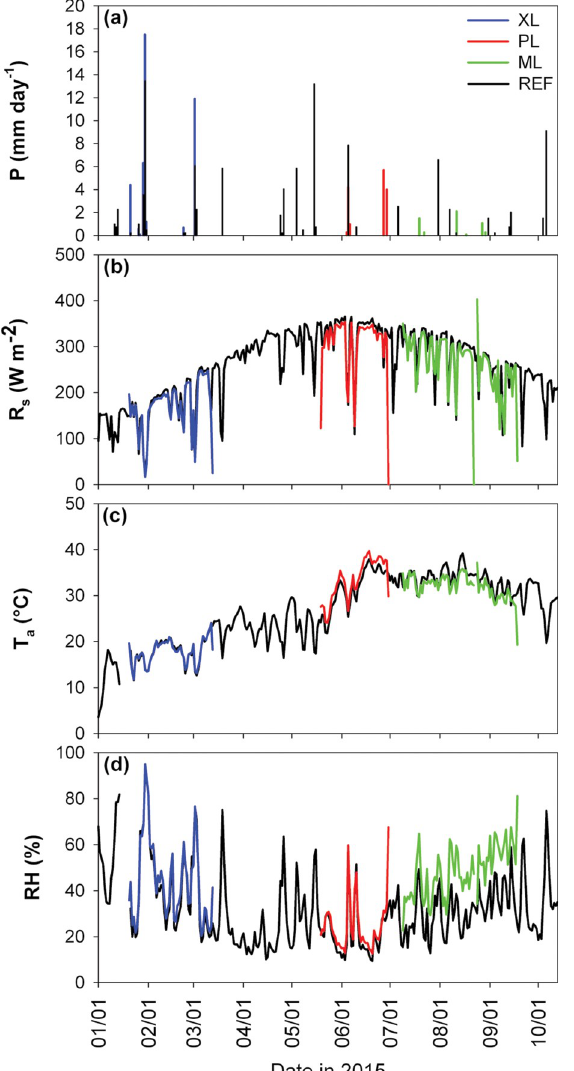
Fig 2. Meteorological conditions in the four sites. Comparison of meteorological measurements during entire study period (1 January to 30 September, 2015) including: (a) precipitation, (b) incoming solar radiation, (c) air temperature, and (d) relative humidity, shown as daily averages ( R , T , and RH ) or totals ( P ). s a https://doi.org/10.1371/journal.pone.0228537.g002 sites including compact low-rise [13,38, 39, 53], compact mid-rise [12,24, 48, 59, 82–86]and com- pact high-rise [50],reported values between 18.7 and 71.7 g CO m -2 day -1 during the summer. The 2 Pearson correlation coefficient (CC) of FC between XL and PL and REF was significant (CC = 0.31 and 0.37, respectively), whereas ML had a much lower, insignificant correlation (CC = -0.15),